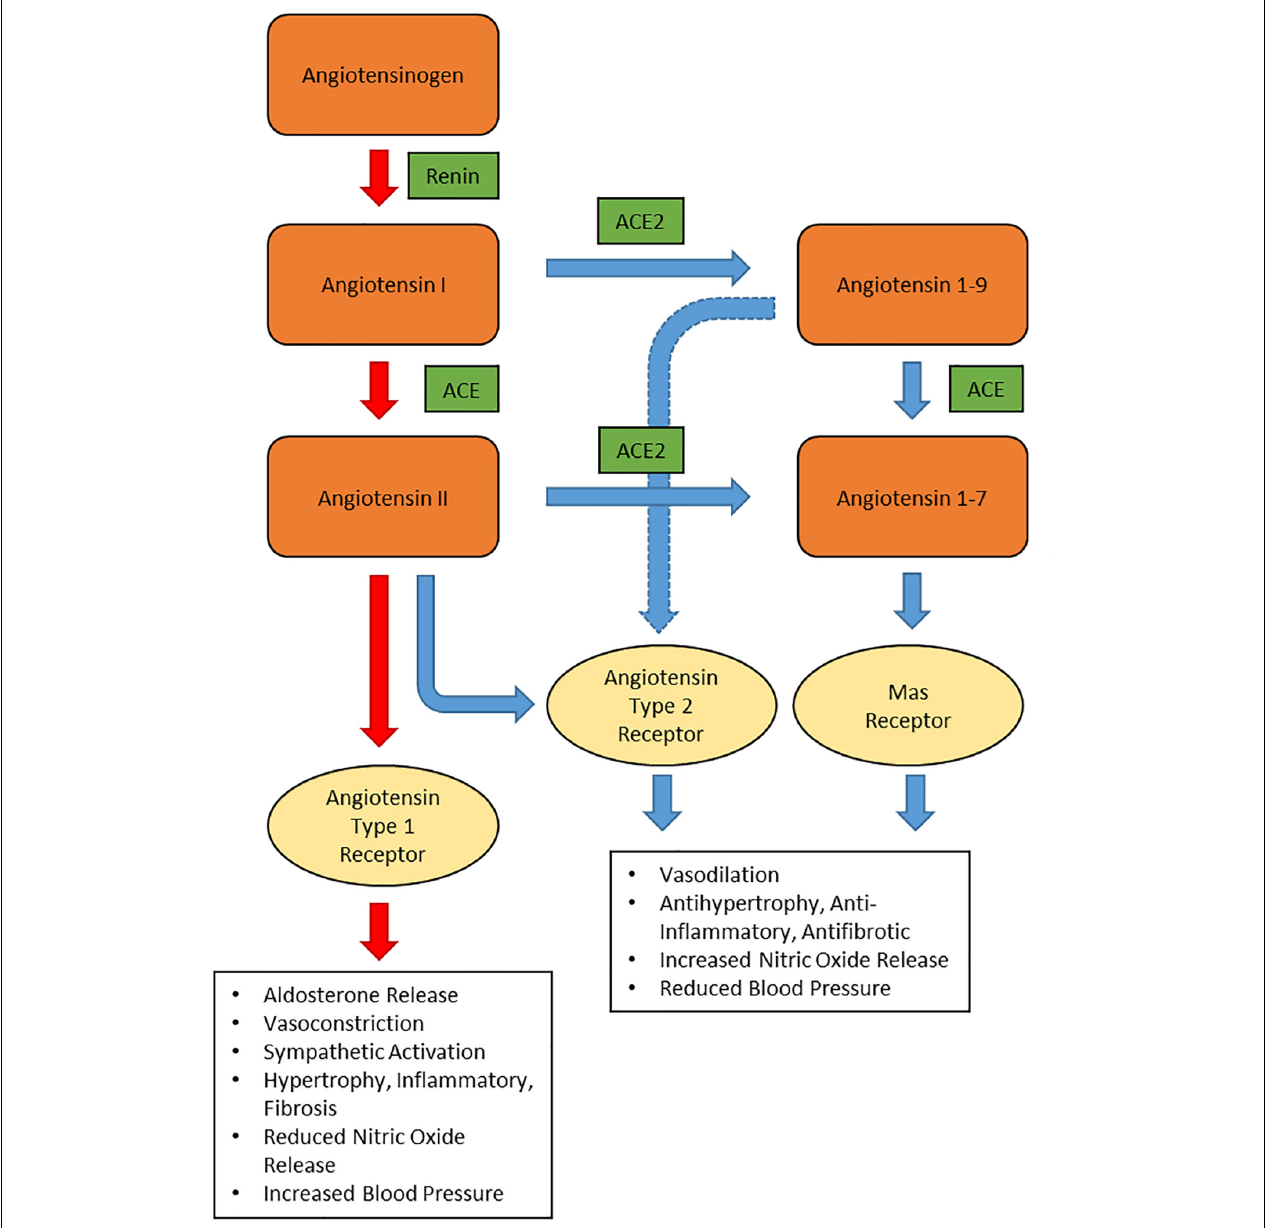
FIGURE 1 | Schematic representation of renin-angiotensin system. ACE: angiotensin converting enzyme, ACE2: angiotensin converting enzyme 2.